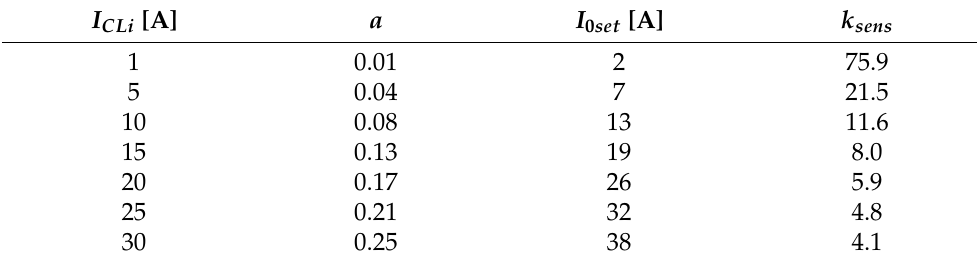
Table 4. Current settings and the corresponding sensitivity factors—compensated network.